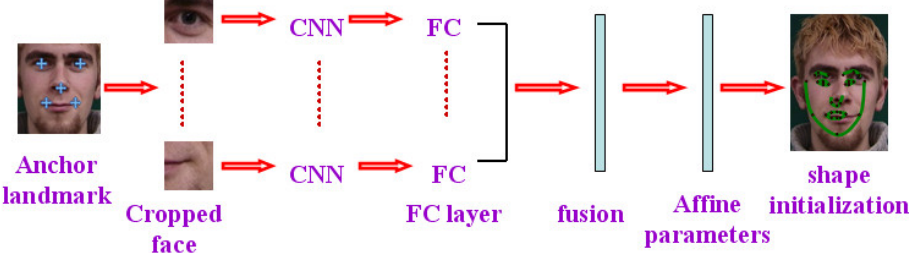
Figure 2. Face shape initialization based on affine parameters regression.